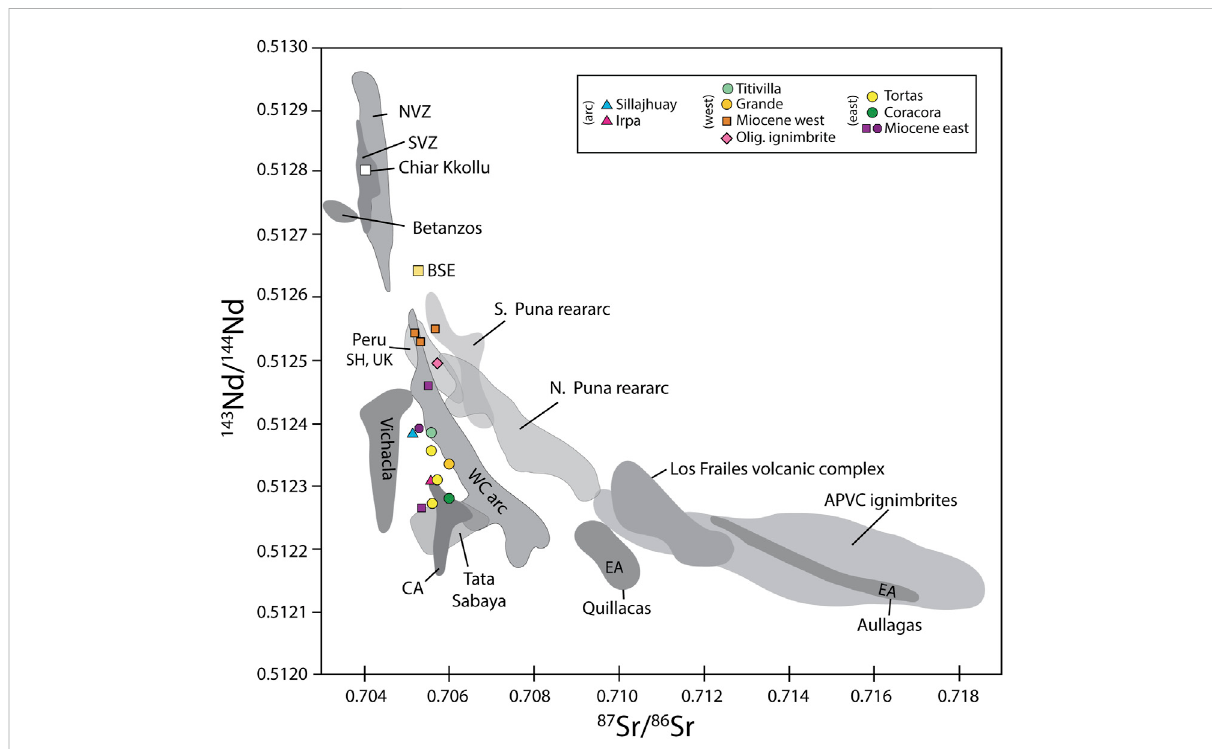
FIGURE 11 87 Sr/ 86 Sr and 143 Nd/ 144 Nd data from the Intersalar Range with select Central Andean igneous rocks for reference. The Western Cordillera (WC) arc array includes Pleistocene centers of Pomerape, Irruputuncu, El Rojo Norte, Olca (Mamani et al., 2010); Aucanquilcha, La Poruñita (Walker 2011); and Ollagüe (Feeley and Davidson, 1994). Reararc centers include Tata Sabaya (de Silva et al., 1993); Chiar Kkollu and other small volume ma fi c rocks of the central Altiplano (CA; Davidson and de Silva, 1995) and eastern Altiplano (EA; McLeod et al., 2012). Reararc ma fi c rocks from the central Altiplano (Chiar Kkollu southern Puna in Argentina (Kay et al., 1994; Drew et al., 2009; Risse et al., 2013), the northern Puna in Argentina (Maro et al., 2017), and the northern Altiplano in Peru (Carlier et al., 2005) are shown for reference. Northern Volcanic Zone (NVZ) and Southern Volcanic Zone fi elds compiled from the GeoROC database 2012 (http://georoc.mpch-mainz.gwdg.de/georoc). Cretaceous rifting-related volcanism of Betanzos and Vichacla from the Bolivian Eastern Cordillera (Lucassen et al., 2007), and the dominantly crustal-derived ignimbrites of Los Frailes (Kato,